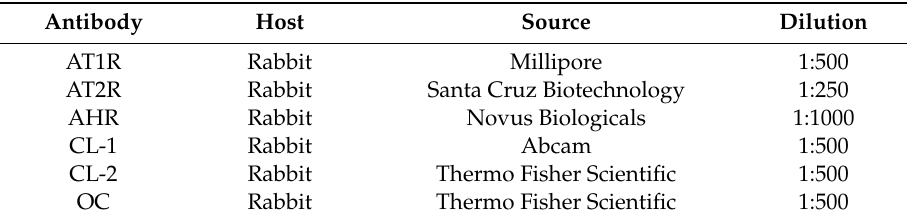
Table 4. Antibodies used for Western